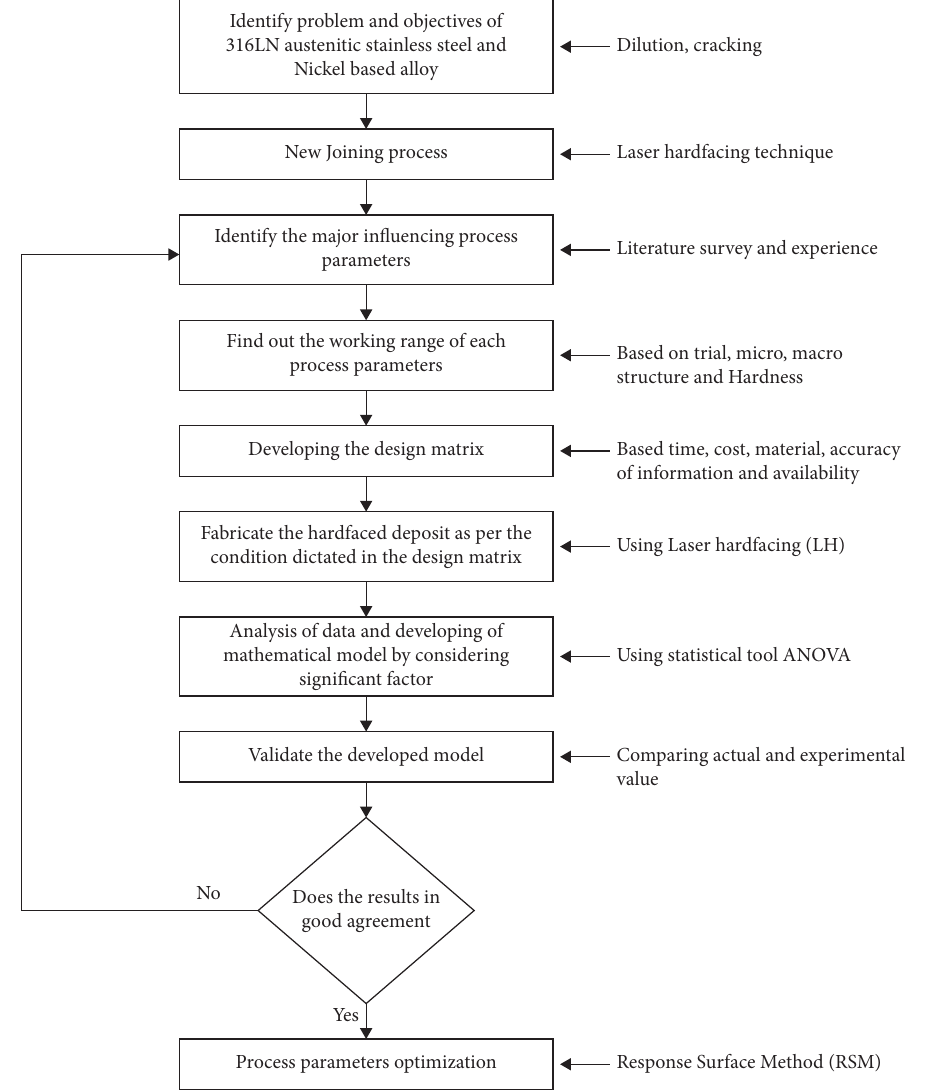
Figure 1: Flow chart for process optimization. Table 1: Fixing the working range of laser hardfacing macrostructure analysis. S.